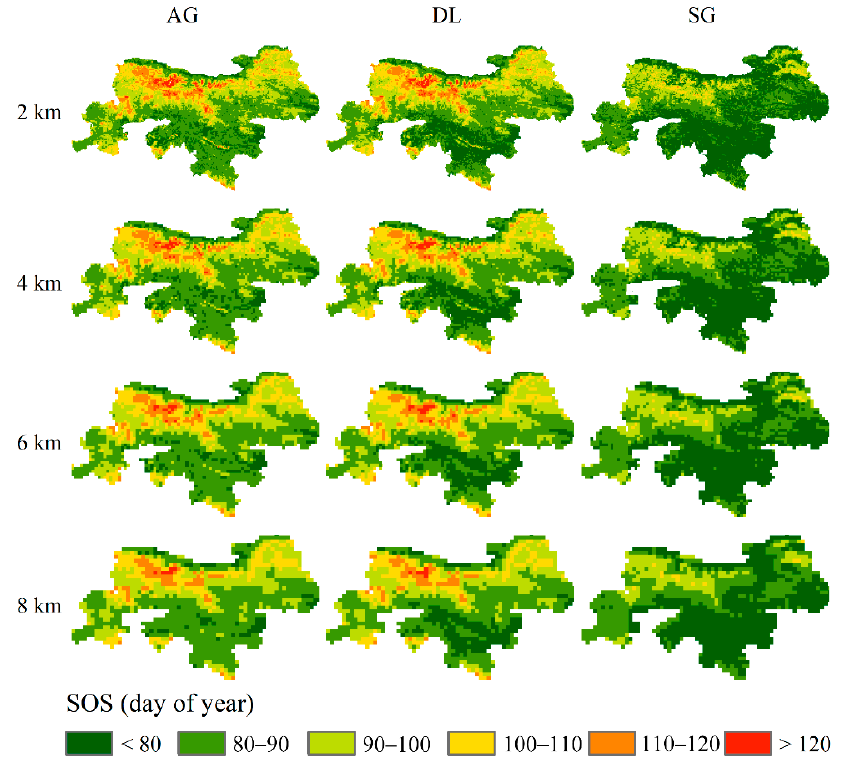
Figure A1. Up-scaled SOSs from 250 m SOSs. (SG, Savitzky-Golay; AG, asymmetric Gaussian; DL, double logistic.)